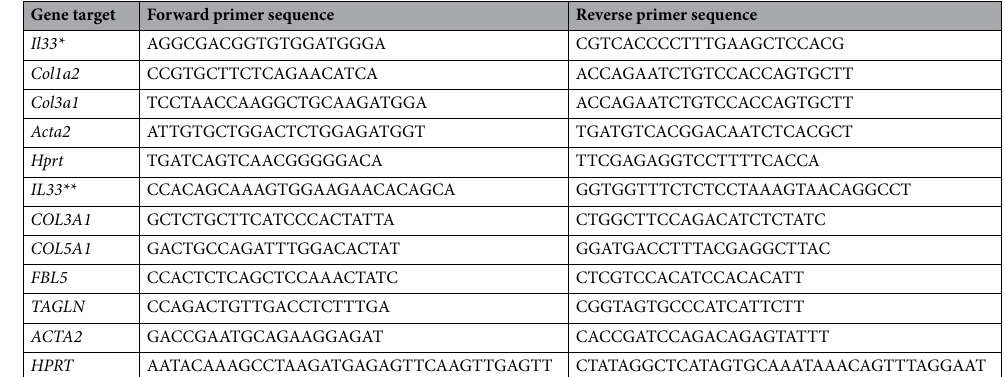
Table 1. Primers used for RT-PCR. *Italicized lower-case characters for mouse genes. **Italicized upper-case characters for human